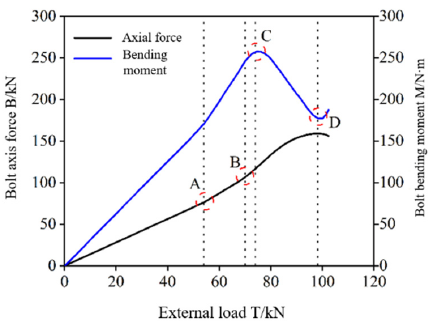
Figure 14. Bolt internal force development curve. Table 4. T-stub finite element model